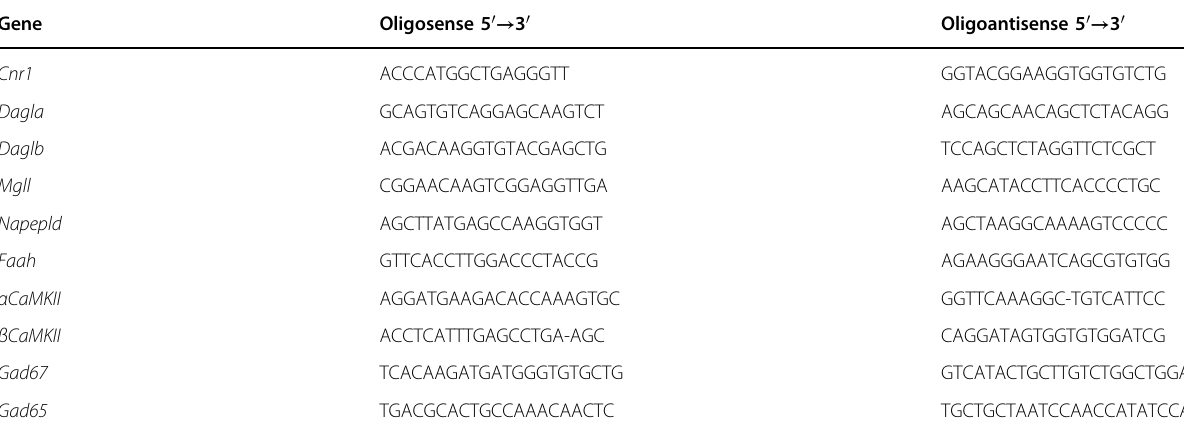
Table 1 Primers sequences used for real-time polymerase chain reaction